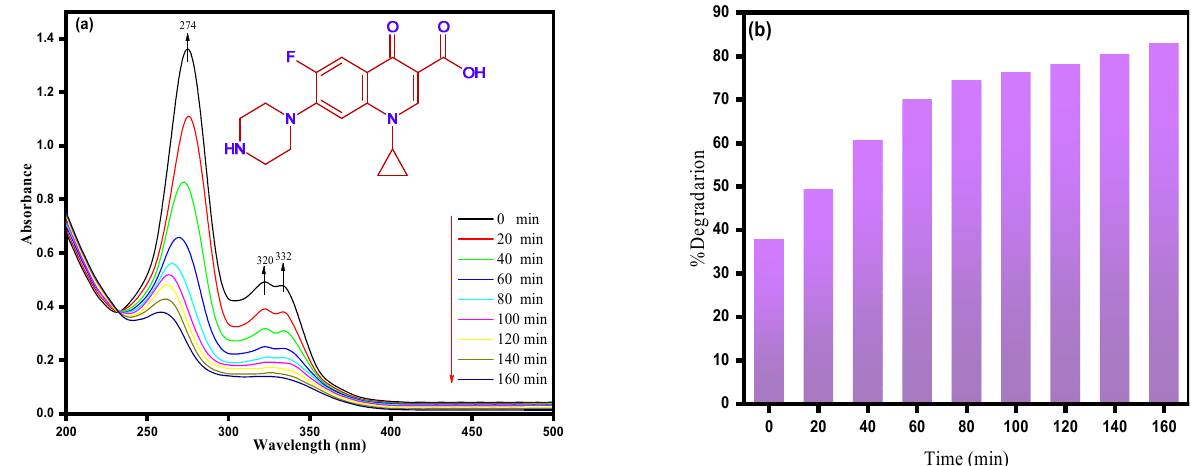
Figure 10. ( a ) Photocatalytic PL-ZnO NP mediated ciprofloxacin (CIP) degradation and ( b ) per- centage degradation vs. time (min) of PL-ZnO NP mediated ciprofloxacin (CIP). degradation vs. time (min) of PL-ZnO NP mediated ciprofloxacin